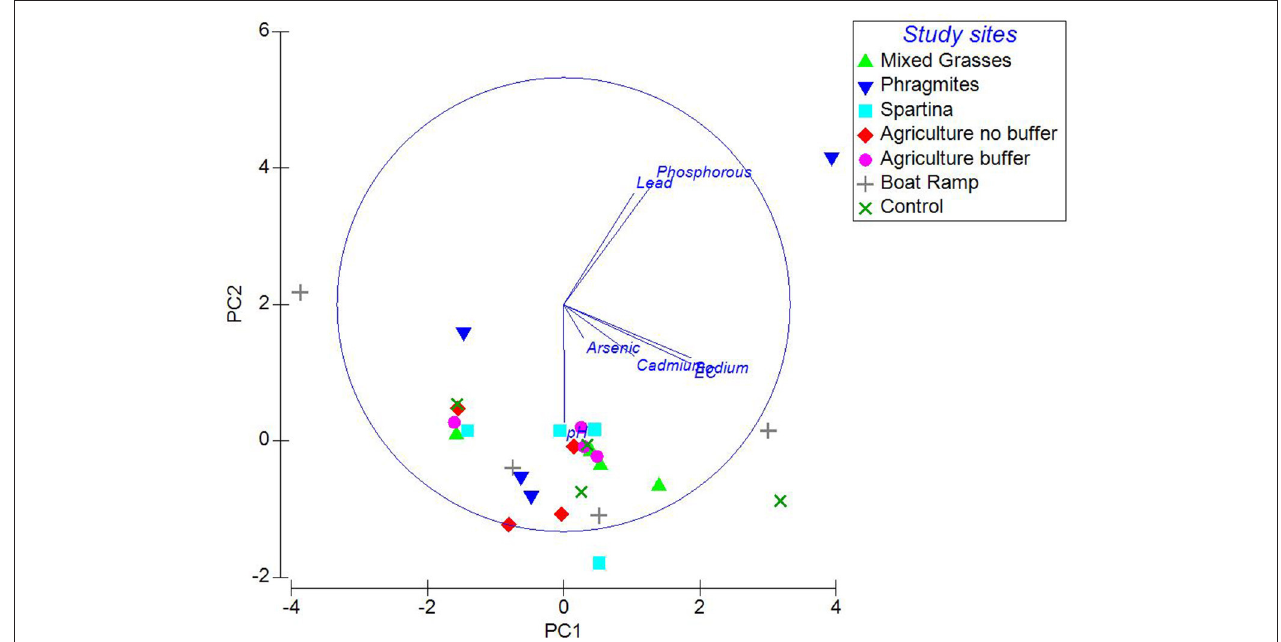
FIGURE 6 | Relationship between electrical conductivity, pH and phosphorous and the heavy metal concentrations of the soil samples.